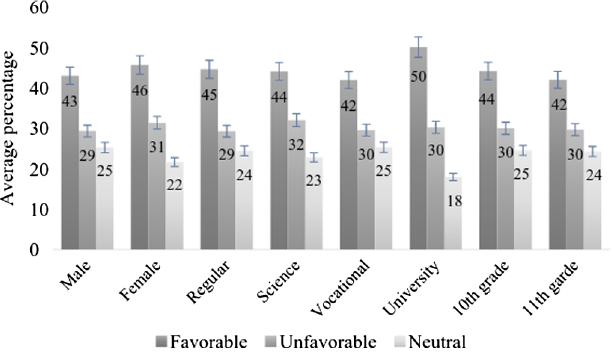
FIG. 1. Average percentages of favorable, unfavorable, and neutral responses for various groups of Turkish students. Because of the blank responses, the sum of percentages for each group does not add up exactly to 100%. Error bars are calculated according to the standard errors for each group. The only statistically significant difference is between the university and vocational high school students ’ favorable